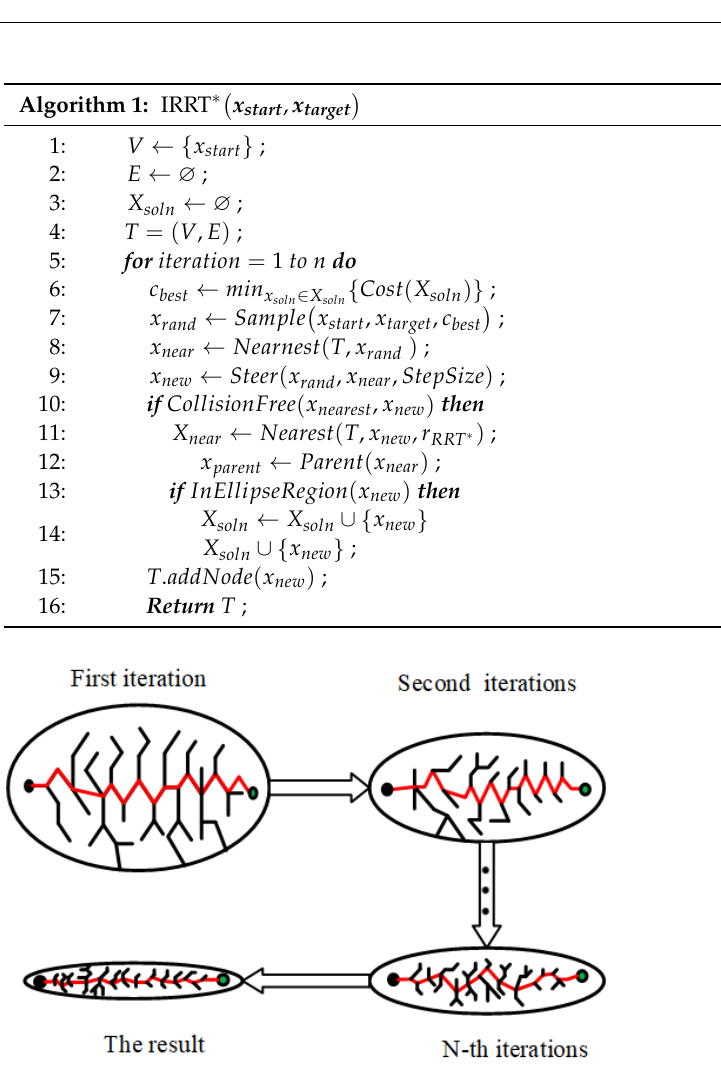
Figure 2. The iterative effect of I-RRT* algorithm.